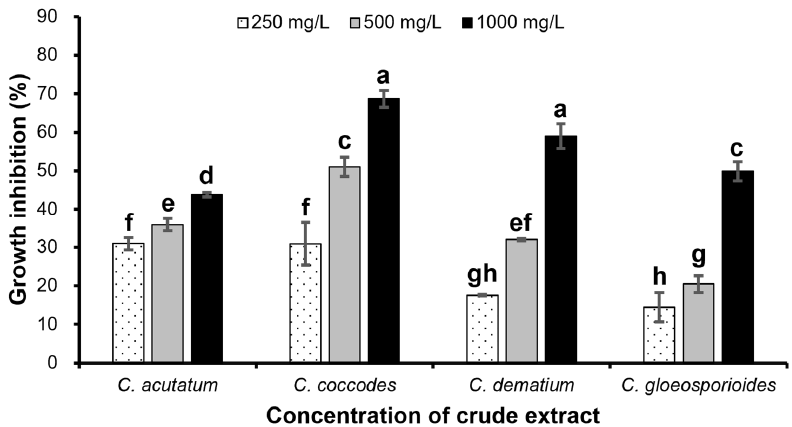
Figure 5. Inhibition of mycelial growth of different Colletotrichum species by chloroform crude extract of B. velezensis CE 100. Histograms represent the mean ± standard deviation of three replications. Different letters represent significant differences (LSD test, p < 0.05).